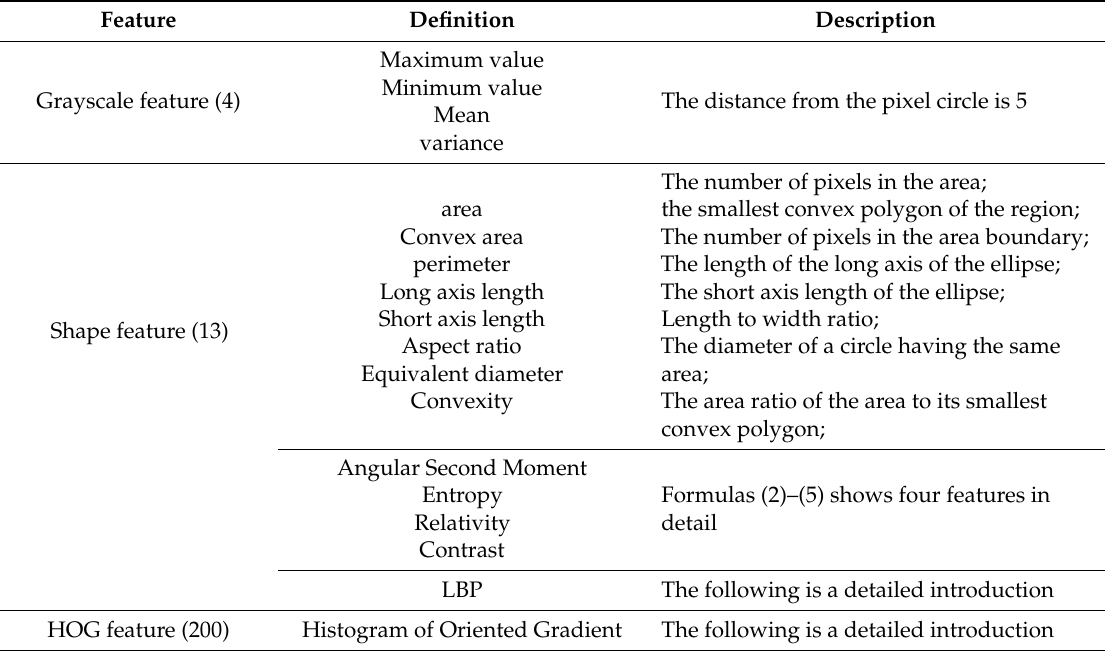
Table 1. Summary of the feature used to describe each region of interest